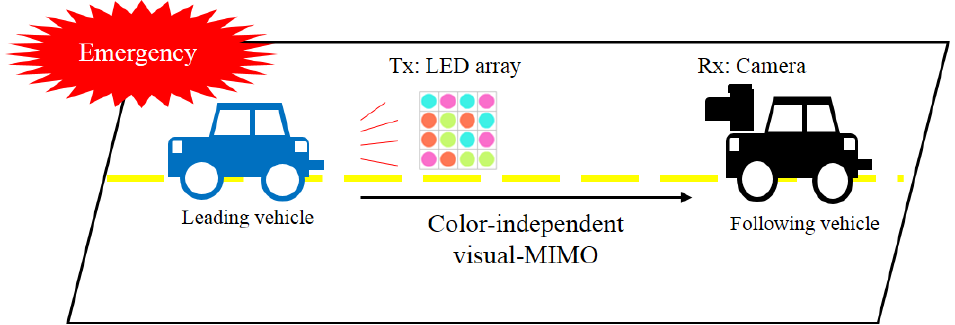
Figure 1. Illustration of the optical V2V communication system.